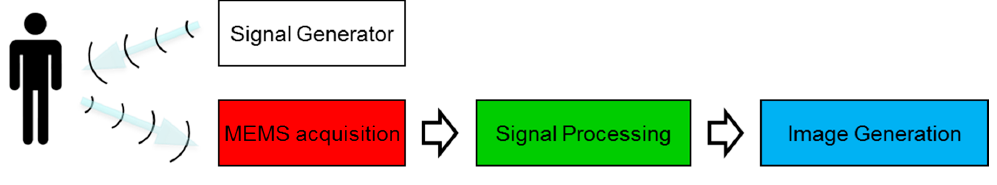
Figure 11. Processing block diagram.